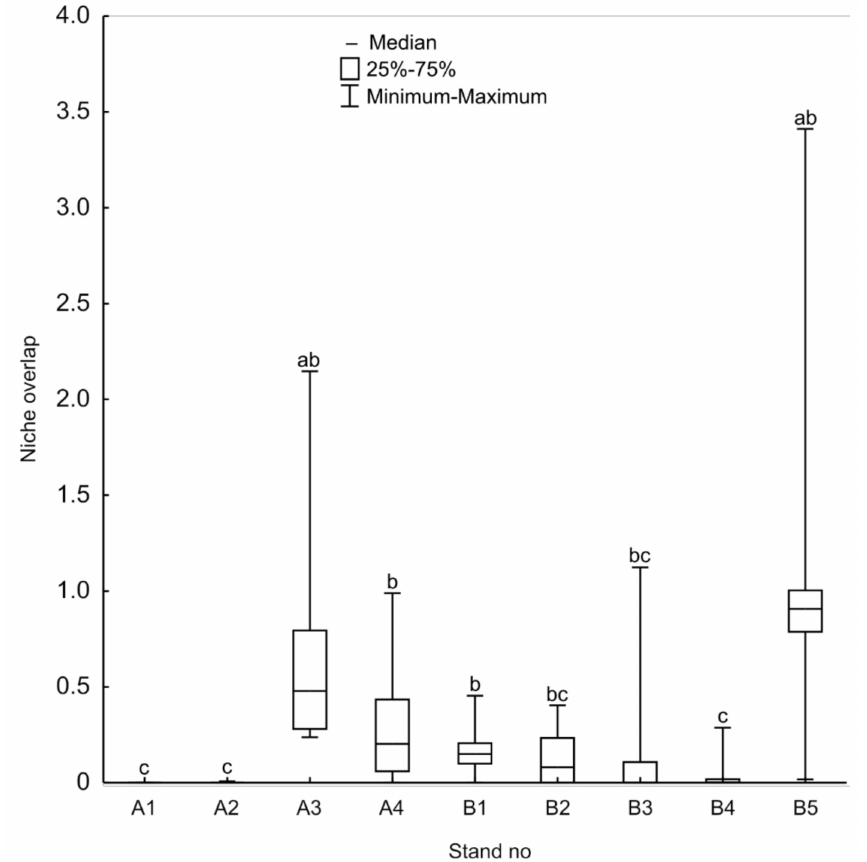
Figure 8. Niche overlaps of the pine shoot beetles colonizing trap logs: a , b , c , the value of niche overlaps (median) marked with different letters indicate statistically significant differences in the stands (Kruskal-Wallis test, p < 0.05).